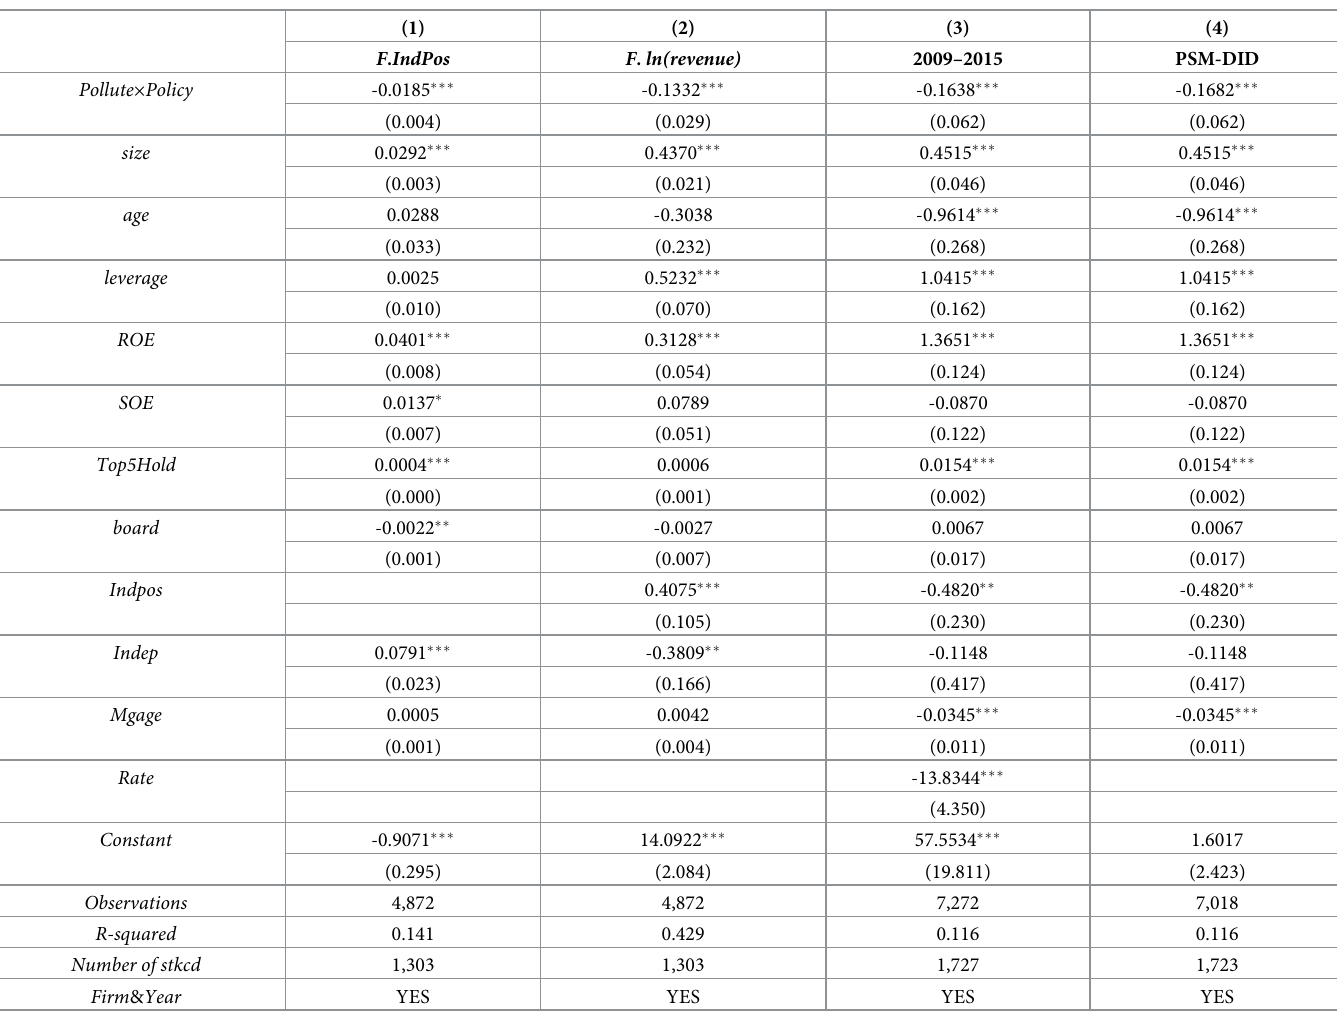
Table 6. Robustness